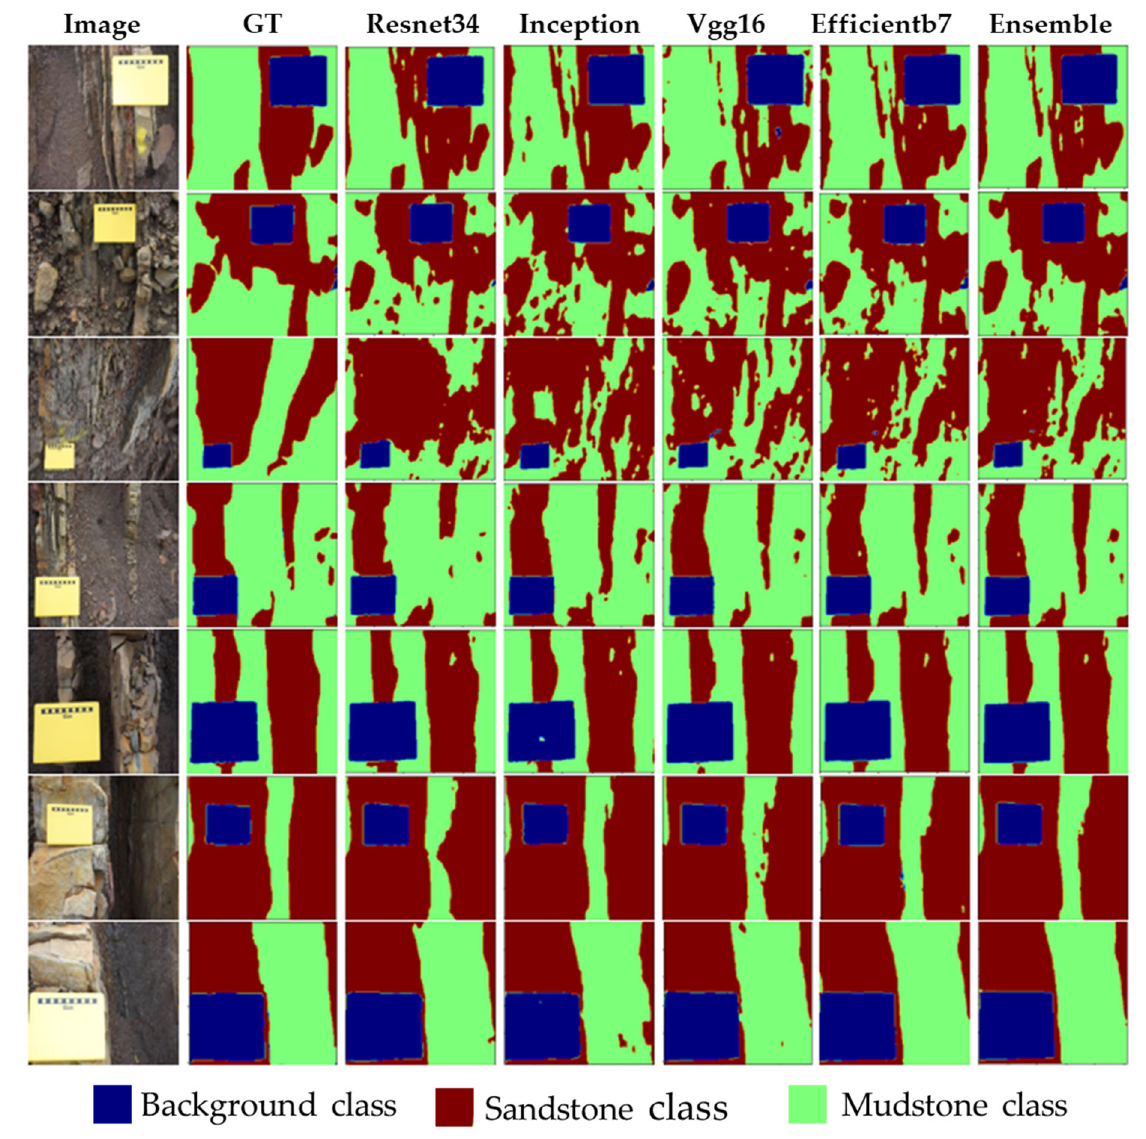
Figure 10. Prediction results for U ‐ Net model with different backbones on a test set.